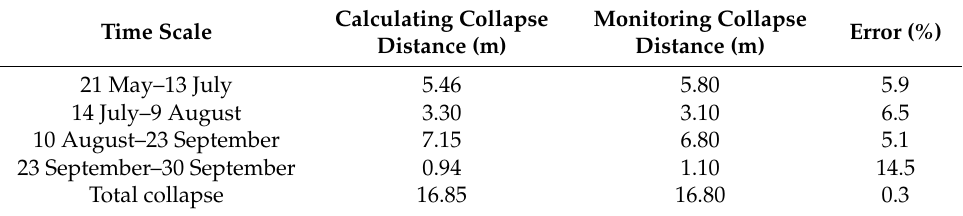
Table 7. Numerical results, field measurements and errors for surveying Section 3 of Figure 1.